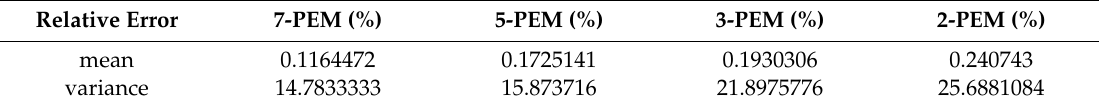
Figure 5. Case 1 results. ( a ) Mean pressure for the natural gas network. ( b ) Variance in pressure for the natural gas network. ( c ) Mean voltage for the power network. ( d ) Variance in voltage for the power network. Table 2. Average relative error of the gas network.